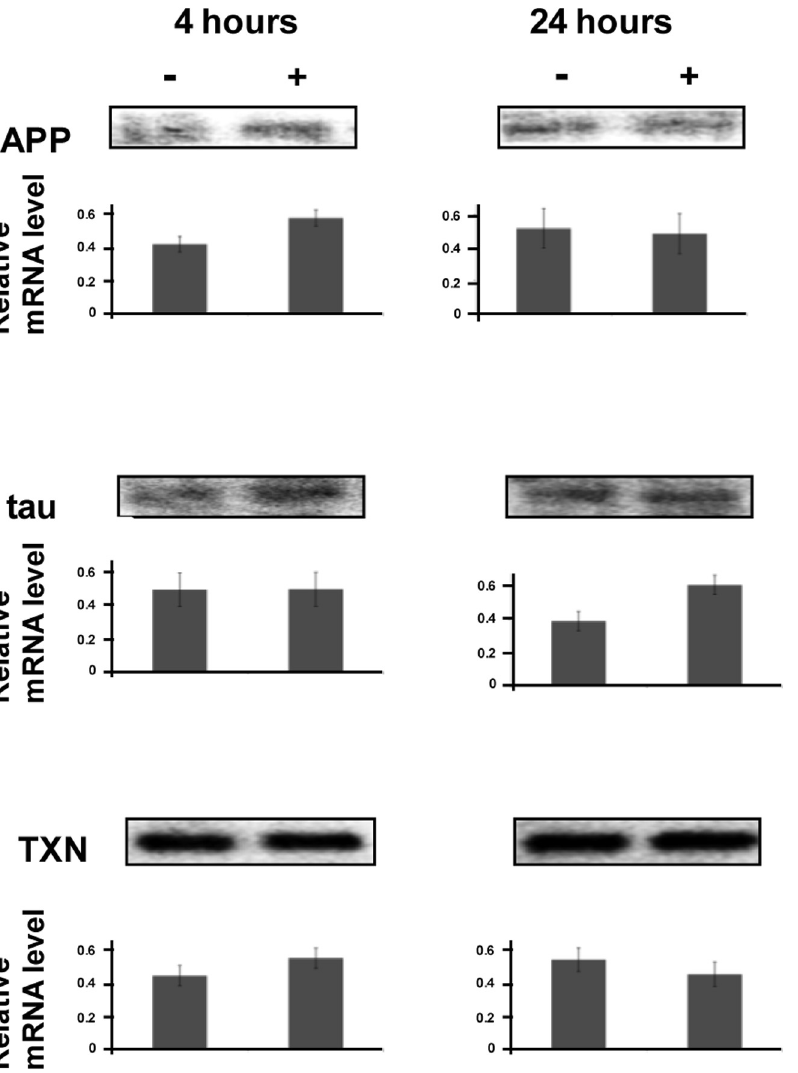
Figure 3. mRNA levels do not account for the change in protein levels following hippuristanol treatment. Northern analysis 4 or 24 hours following 10 minutes 10 m M hippuristanol treatment, using probes specific to APP, TAU, Actin and TXN, indicates no significant decrease in these mRNA levels. Mean relative proportions of RNA with standard errors are indicated in the charts beneath each gel image.